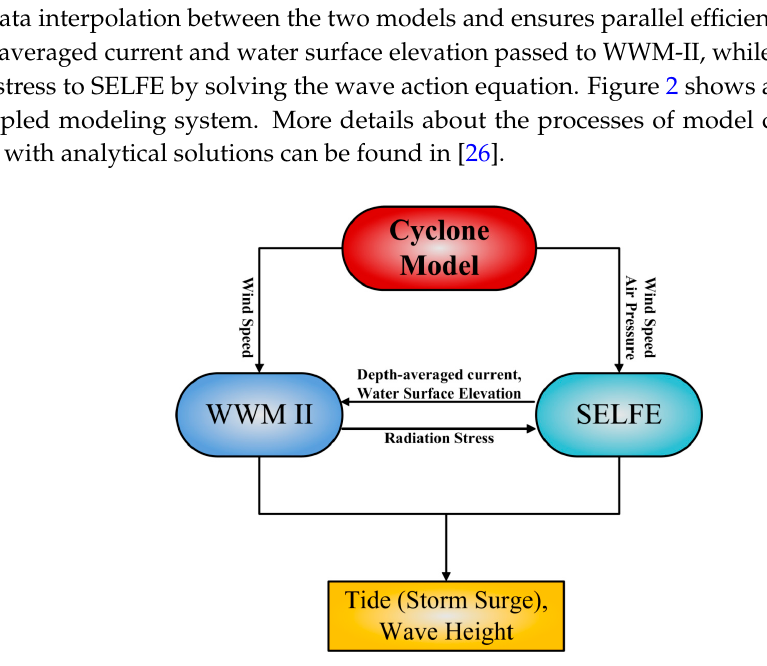
Figure 2. Schematic diagram for the coupled model.